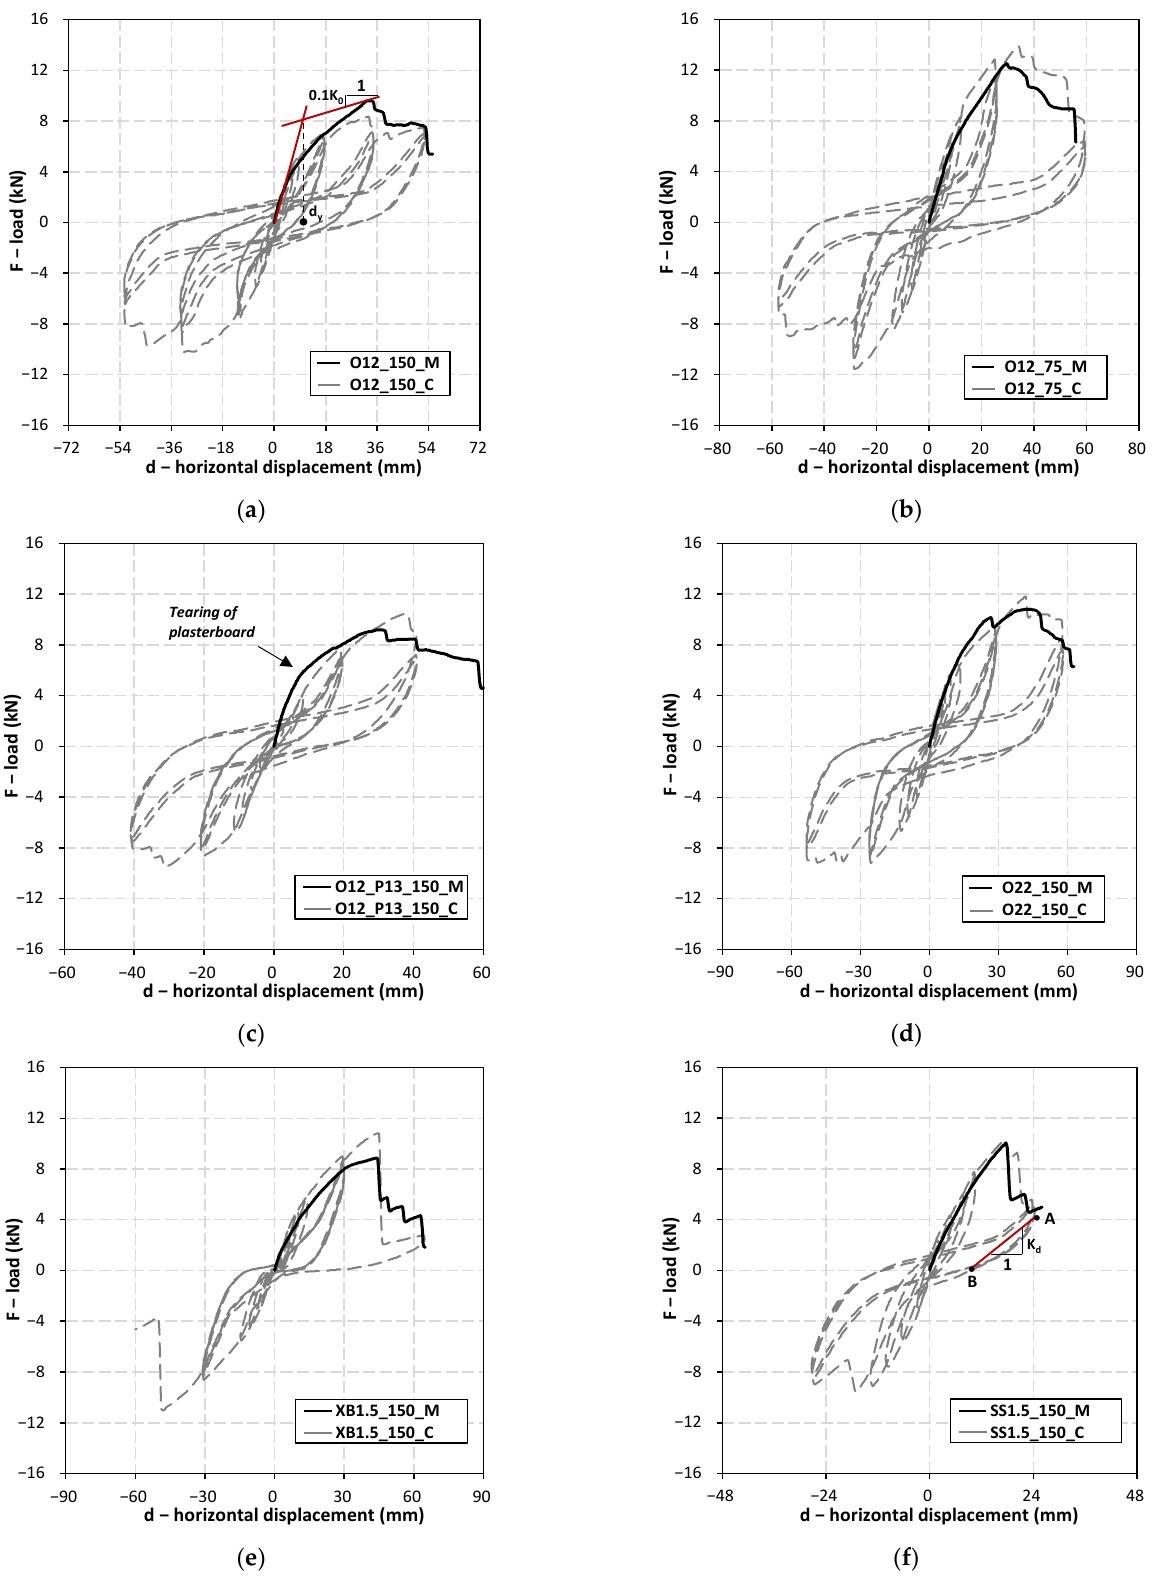
Figure 3. Load vs. horizontal displacement of the tested walls: ( a ) O12_150_M and O12_150_C, ( b ) O12_75_M and O12_75_C, ( c ) O12_P13_150_M and O12_P13_150_C, ( d ) O22_150_M